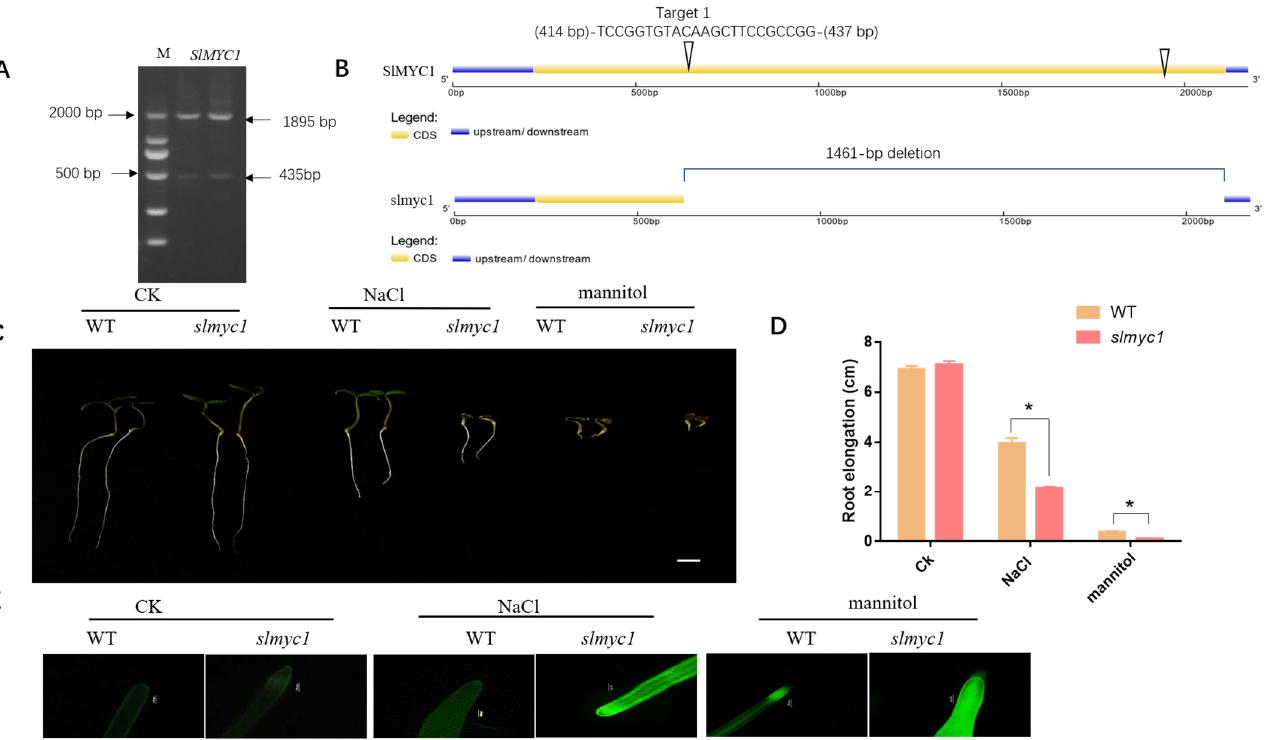
Figure 9. CRISPR/Cas9-mediated mutation of the SlMYC gene and the response of slmyc1 to NaCl and mannitol stress. ( A ) The size of DNA fragments amplified by PCR with genomic DNA. M: DNA marker. ( B ) Schematic diagram of the sgRNA target sites on the SlMYC1 gene and the sequencing results of the sequence near the mutation site of the SlMYC1 gene. M: marker. ( C ) Growth of the slmyc1 mutant and wild-type (WT) seeds after 96 h of NaCl and mannitol treatment. The tomato nutrient solution treatment was employed as a control (CK). ( D ) Statistical analysis of the root length of the slmyc1 mutant and the WT at 96 h after NaCl and mannitol treatment ( p -values less than 0.05 are summarized with one asterisk. ( E ) Determination of ROS content in root tips of the slmyc1 mutant after 96 h of NaCl and mannitol treatment.